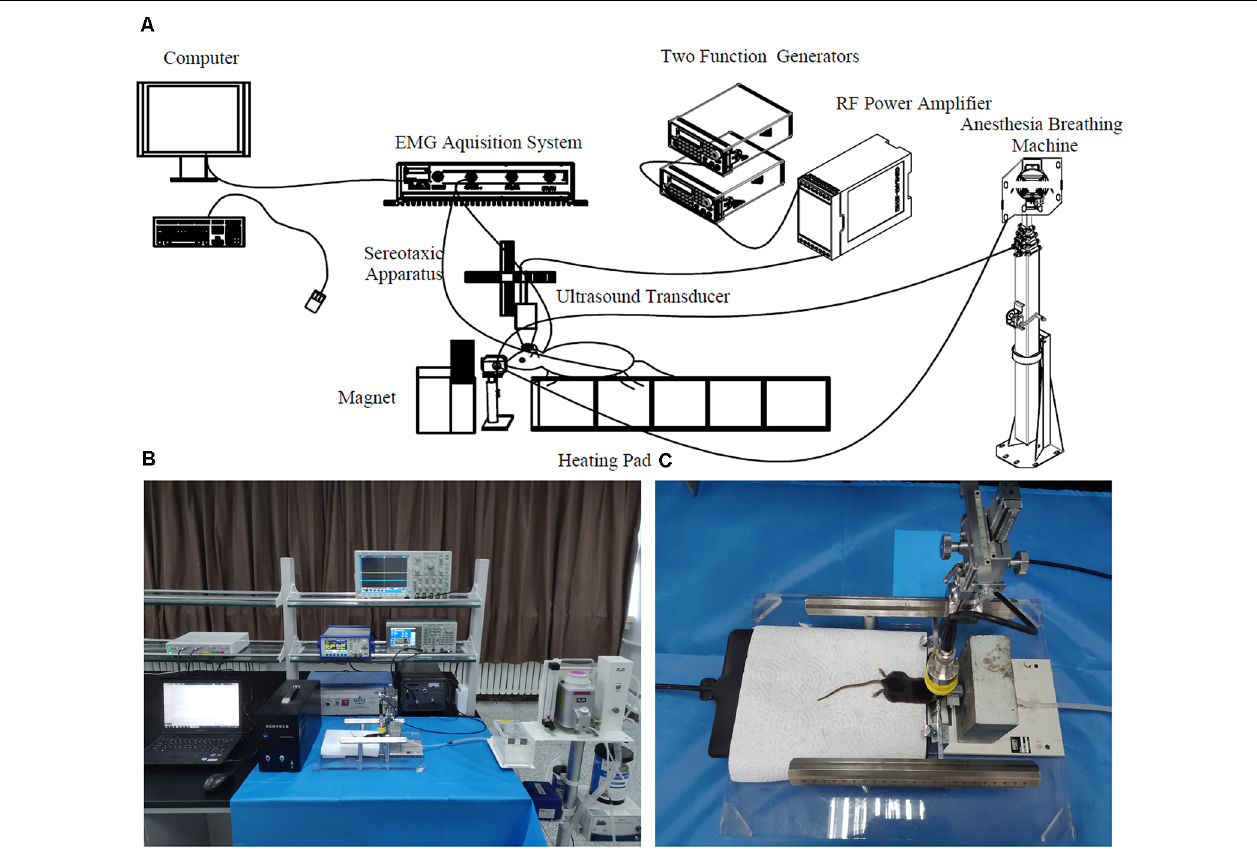
FIGURE 1 | Transcranial ultrasound stimulation (TUS)-transcranial magneto-acoustic stimulation (TMAS) experimental system. (A) Diagram of TMAS-TUS experimental system. The ultrasonic stimulation signal is generated by two function signal generators and the ultrasonic transducer is driven by a power amplifier amplified 100 times. The ultrasonic transducer is fixed by the three-axis bracket of the stereotactic locator and the target is stimulated by adjusting the three-axis coordinates. The mouth of the mouse was fixed on a holder with anesthetic gas and its body was fixed on a plate with a heating pad. The depth of anesthesia was maintained by a breathing anesthesia machine. electromyography (EMG) signals of the mouse were collected by a needle electrode and acquired by a multi-channel physiological record acquisition system. (B) Map of TMAS experimental platform. The TUS stimulation was performed by removing the magnet in front of the mouse’s head. (C) Mouse subjected to